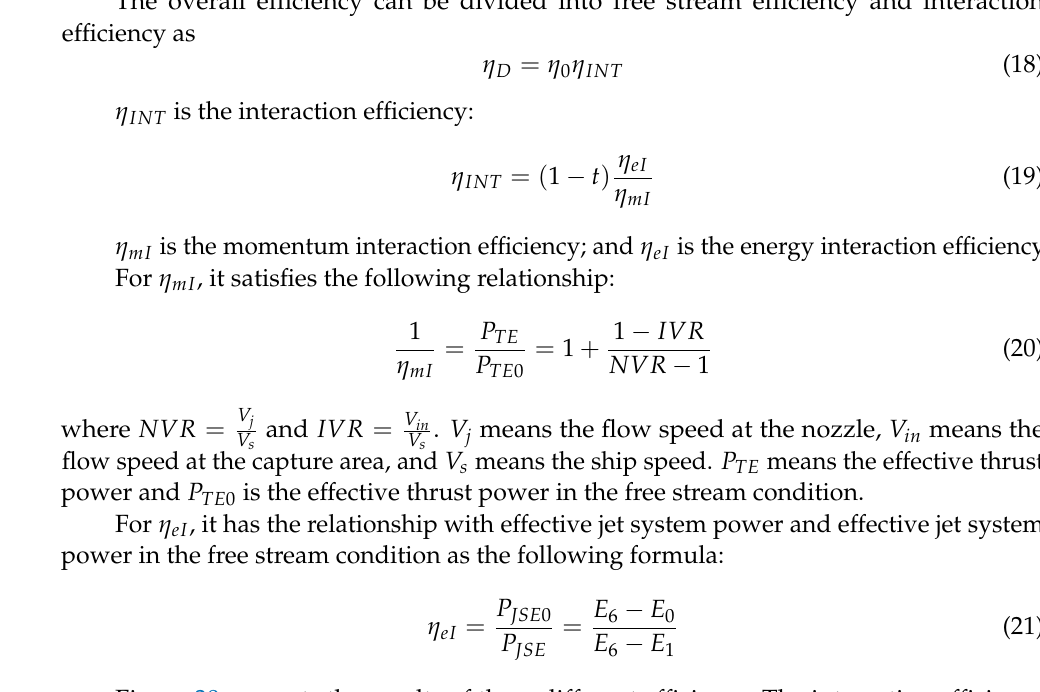
Figure 31. Comparison of the overall efficiency between EFD and CFD. 6. Conclusions This paper presents the research about a waterjet propelled catamaran. The simula- tions of the bare hull and self-propulsion hull are conducted using an in-house solver. The pump effect of the rotor is simulated by a body force model to save computing costs of the simulations. Moreover, the simulation results of the bare hull and self-propulsion hull are compared in detail to analyze the hull effect on the waterjet system. In addition, the characteristic of the waterjet system as well as the waterjet–hull interaction are analyzed according to the ITTC recommended procedures. The conclusions are as follows: 1.